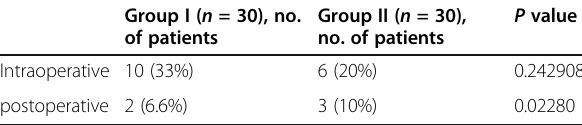
Table 3 Requirement of intraoperative and postoperative analgesics